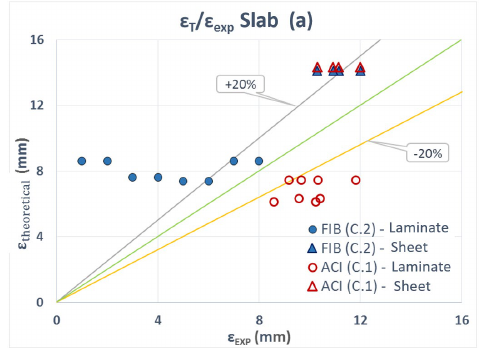
Figure 2. ACI440 x FIB - Analysis of the ultimate strain ( / theoretical exp   ) for slabs (a).